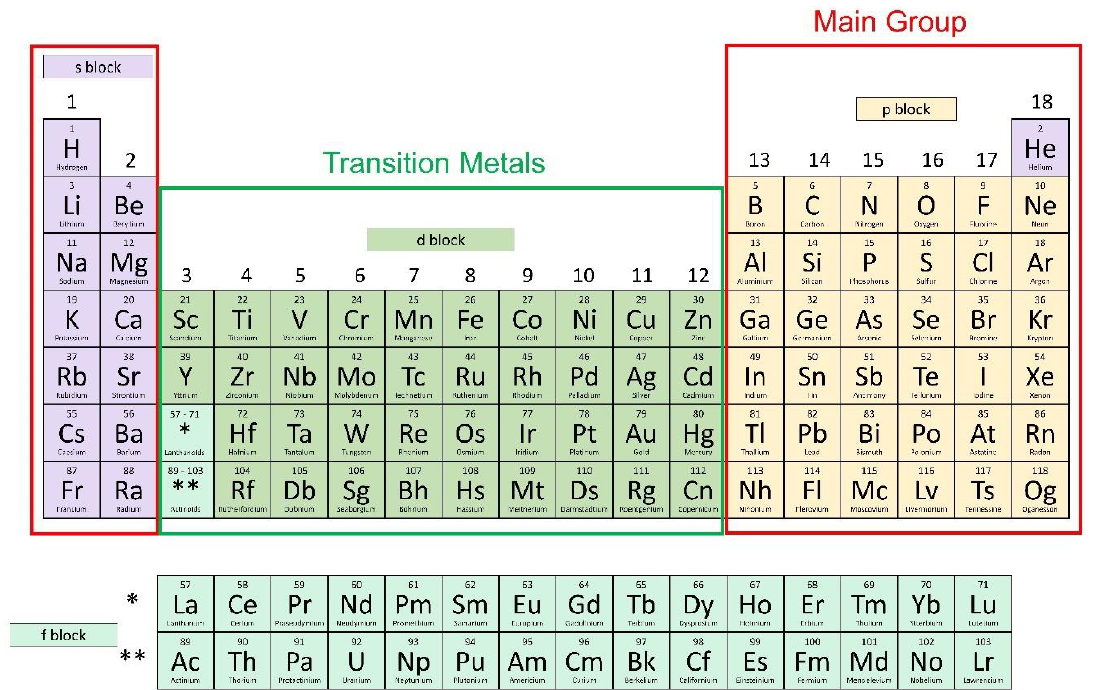
Figure 1. Divisions within the periodic table of elements. Figure adapted from work by Dr M. Haddow (University of Edinburgh), with permission.